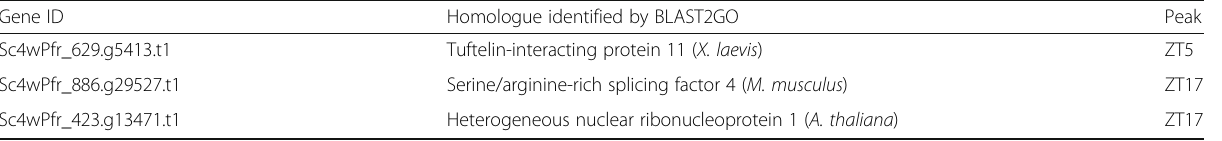
Table 3 RNA processing-associated genes exhibiting a diel expression pattern Gene ID Homologue identified by BLAST2GO